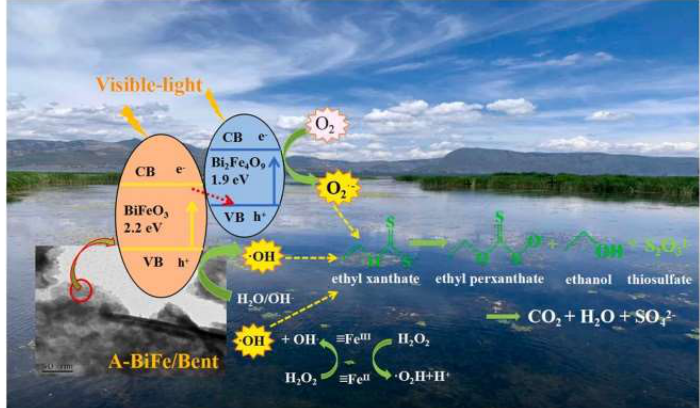
Figure 7. Mechanism of A-BiFe/Bent-catalyzed degradation of EX under visible light (reproduced from Opt. Mater. 2022, 132 with permission from Elsevier) [85].